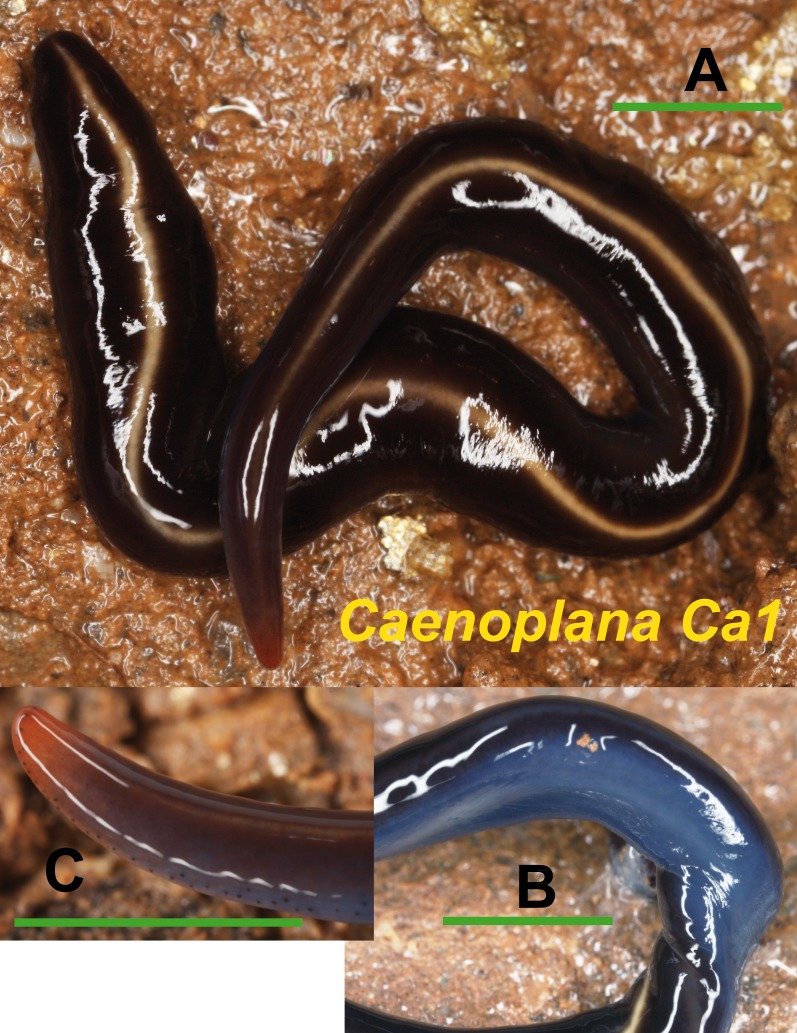
Caenoplana morph Ca1.(A) Dorsal view. (B) Ventral view of median part. (C) Lateral view of anterior end showing line of eyes. Scale bar 5 mm.